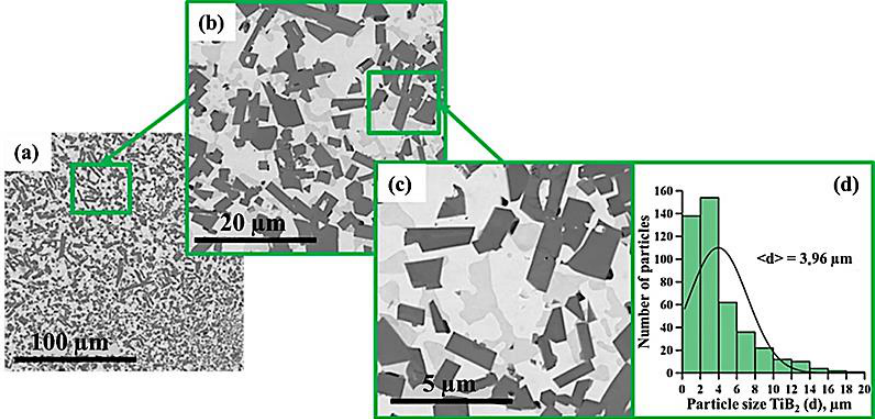
Figure 8. SEM image of the structure of a composite fabricated by direct laser deposition from the Inconel 625 + 50 wt% NiTi – TiB 2 powder mixture ( a – c ), histogram of the distribution of ceramic inclusions by size ( d ).